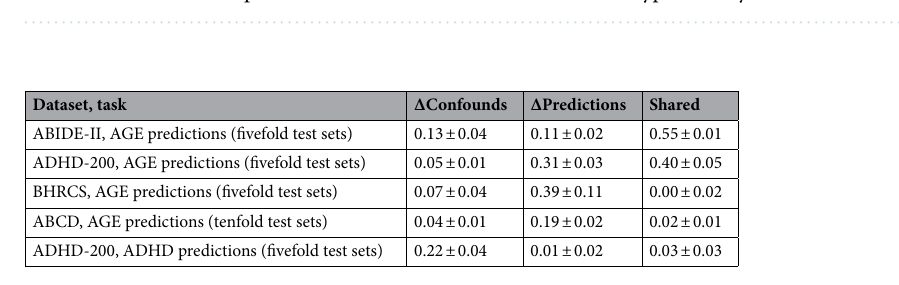
Table 3. Classification performance metrics. The performance metrics are in mean values ± standard deviation. ASD Autism spectrum disorder, ADHD Attention deficit hyperactivity disorder.